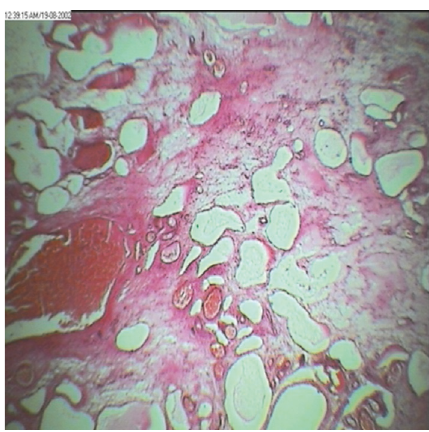
Figure 3: Microscopic appearance of tumor